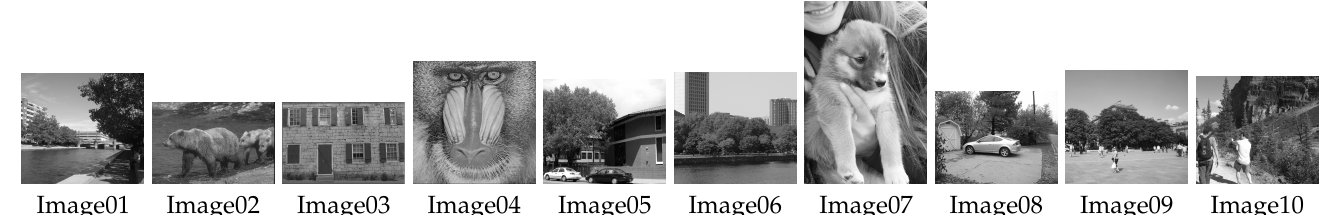
Figure 3. Dataset I: The ten test images from [21] used in the